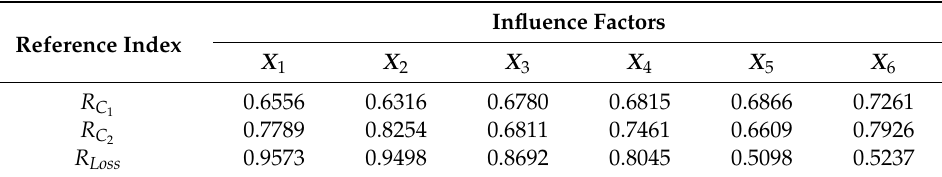
Table 5. Correlation degrees of LVC-qZSI